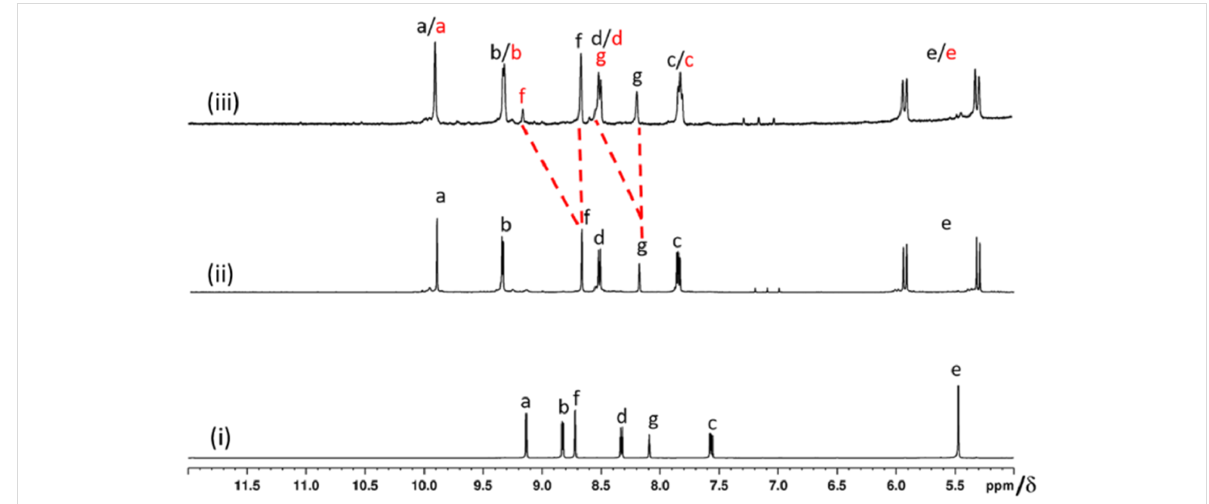
Figure 2: Partial 1 H NMR spectra in DMSO- d 6 for (i) L1 , (ii) [Pd(tmeda)( L1 )](NO 3 ) 2 ( 1a ) and (iii) a mixture of [Pd(tmeda)( L1 )](NO 3 ) 2 ( 1a ) and [Pd 3 (tmeda) 3 ( L1 ) 2 ](NO 3 ) 6 ( 2a